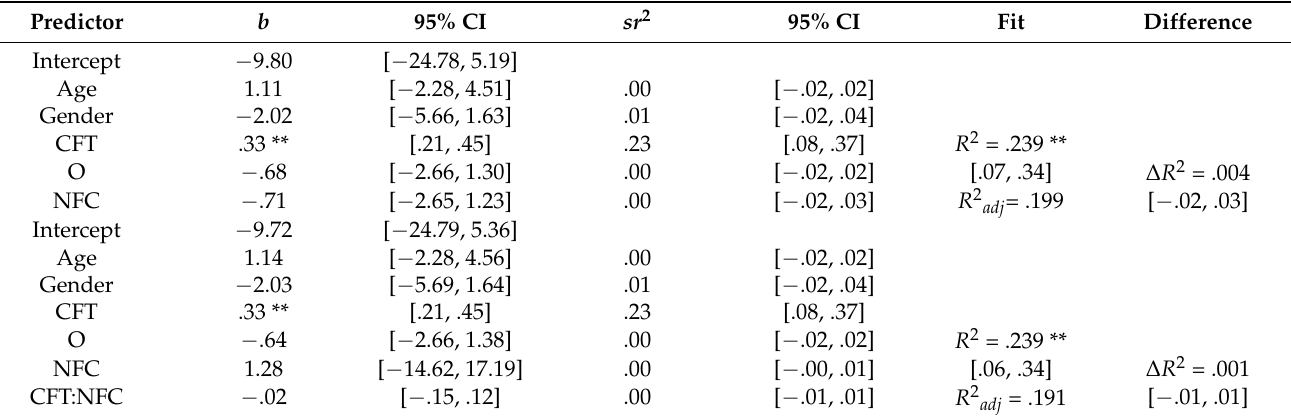
Table 6. Regression mathematical abilities onto fluid intelligence, openness, and need for